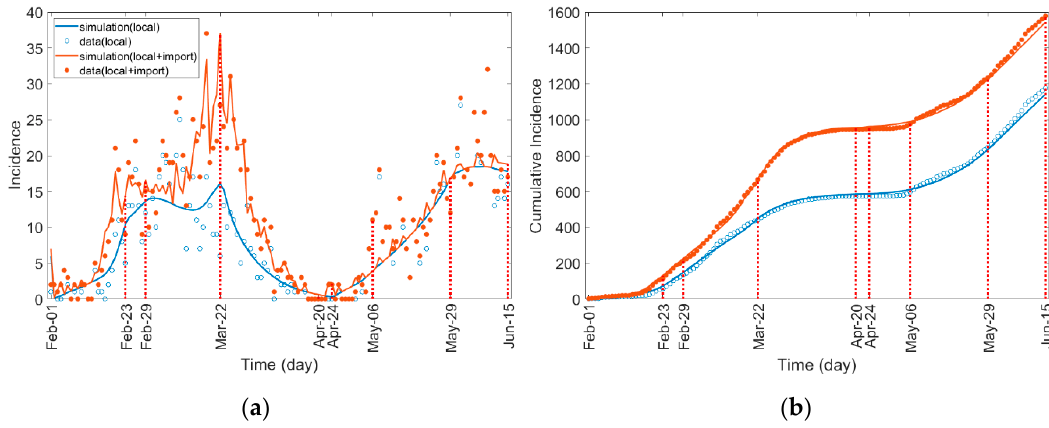
Figure 5. Incidence and cumulative incidence of all ages. Incidences by local transmission (local and imported transmission) are blue-colored